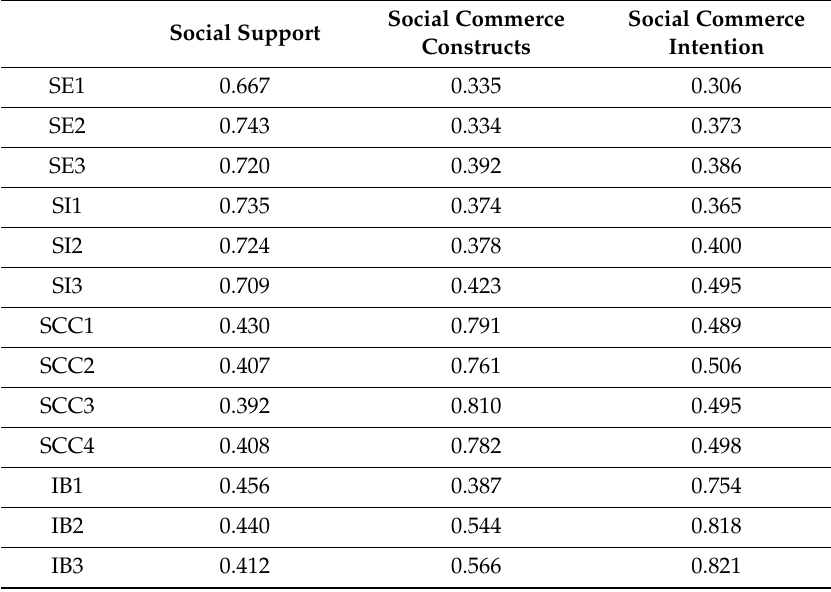
Table 4. Cross-loading matrix.